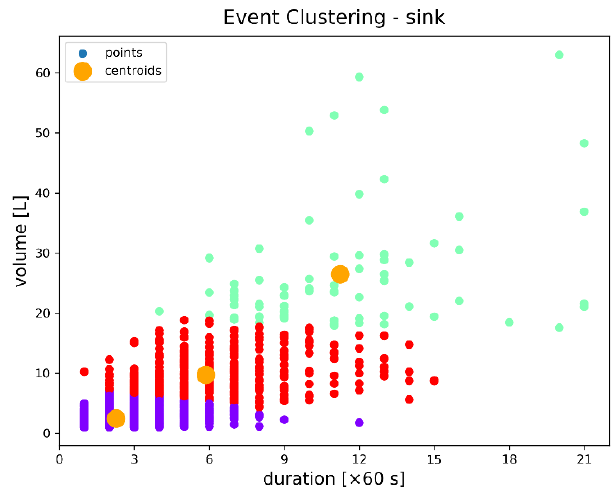
Figure 7. Consumption event clustering — sink.